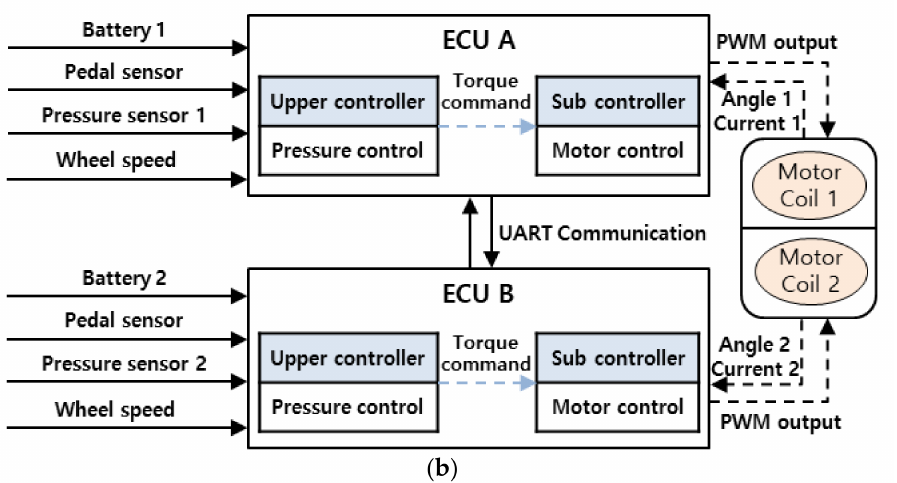
Figure 1. Configuration of the redundant electro-hydraulic brake system: ( a ) flowchart of the brake operation and ( b ) schematics of the dual ECUs and